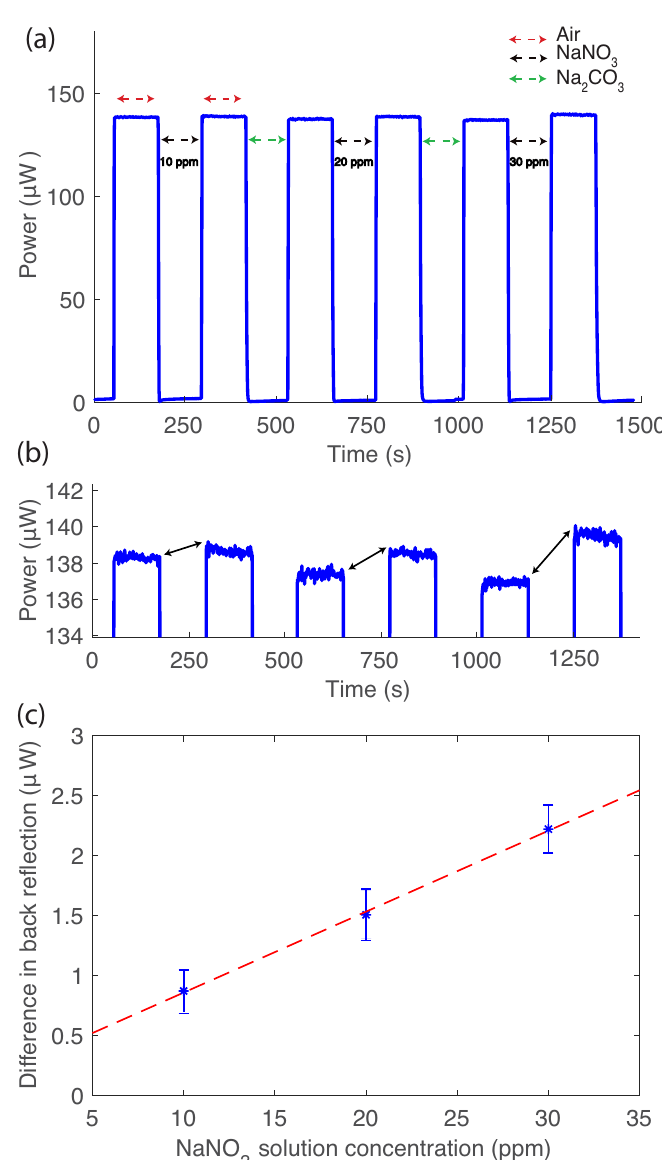
Figure 5. Response time of the sensor. ( a ) Three cycles of NaNO 3 and Na 2 CO 3 with 2 min in solution and 2 min in air for different NO − concentration of 10, 20 and 30 ppm, respectively, ( b ) zoomed 3 in section of part a, the black double arrow shows the difference in back reflection before and after exposure to NaNO 3 , and ( c ) the difference in back reflection light intensity is plotted against the NaNO − concentration. The blue stars with error bars represent the experimental data and the red 3 dashed line represents the linear regression